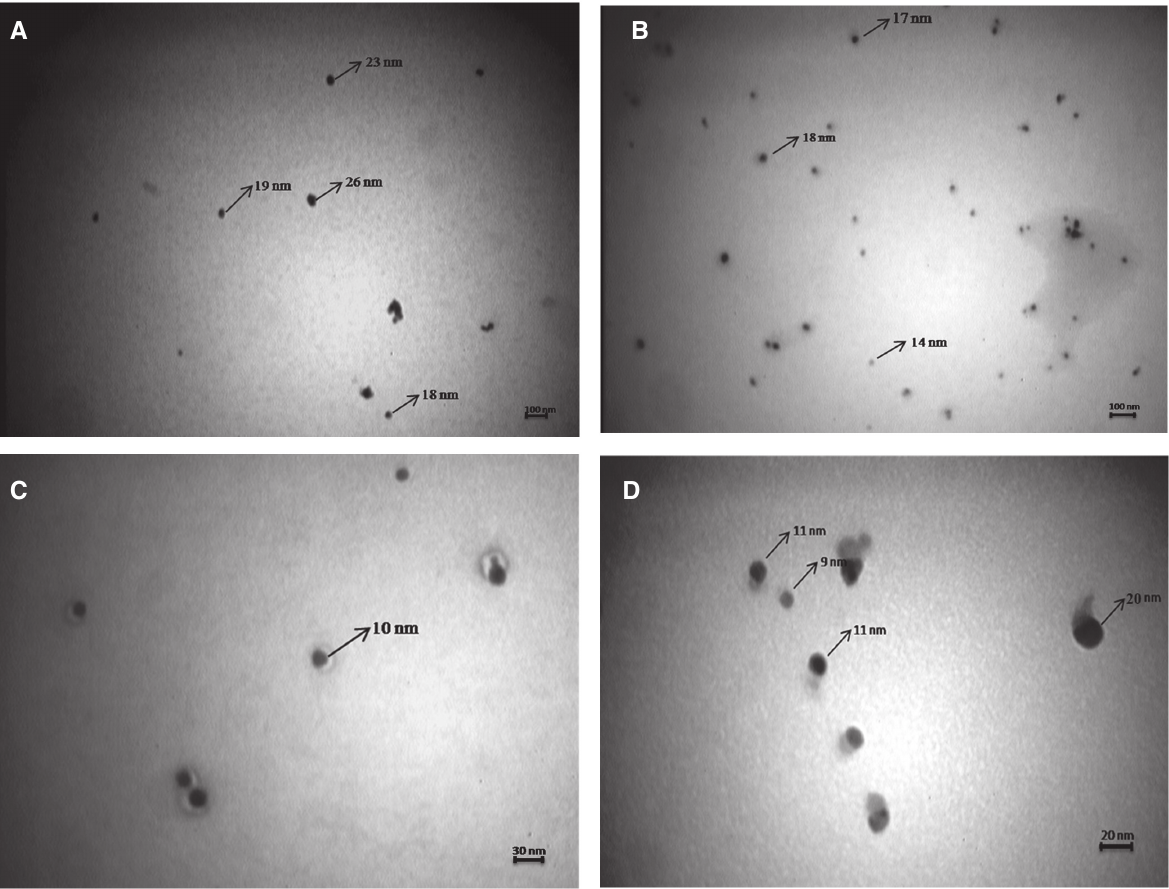
Figure 4 Transmission electron microscopy (TEM) micrographs recorded from a drop-coated film of an aqueous solution of Ag + ions incubated with freshly cultured S. boulardii (after 5 h biotransformation). Magnifications are: (A) 16,000, (B) 20,000, (C) 63,000 and (D)